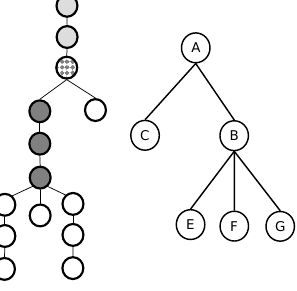
Figure 5: Aggregation of features B and C. The merged contour (hashed) is part of feature A. Features B and C are defined with new boundary